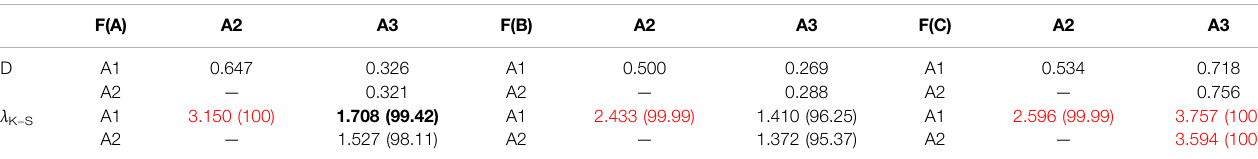
TABLE 5 | The Kolmogorov-Smirnov two-sample statistic λ K − S applied to F(coef), the Sample size are in Table 1 .